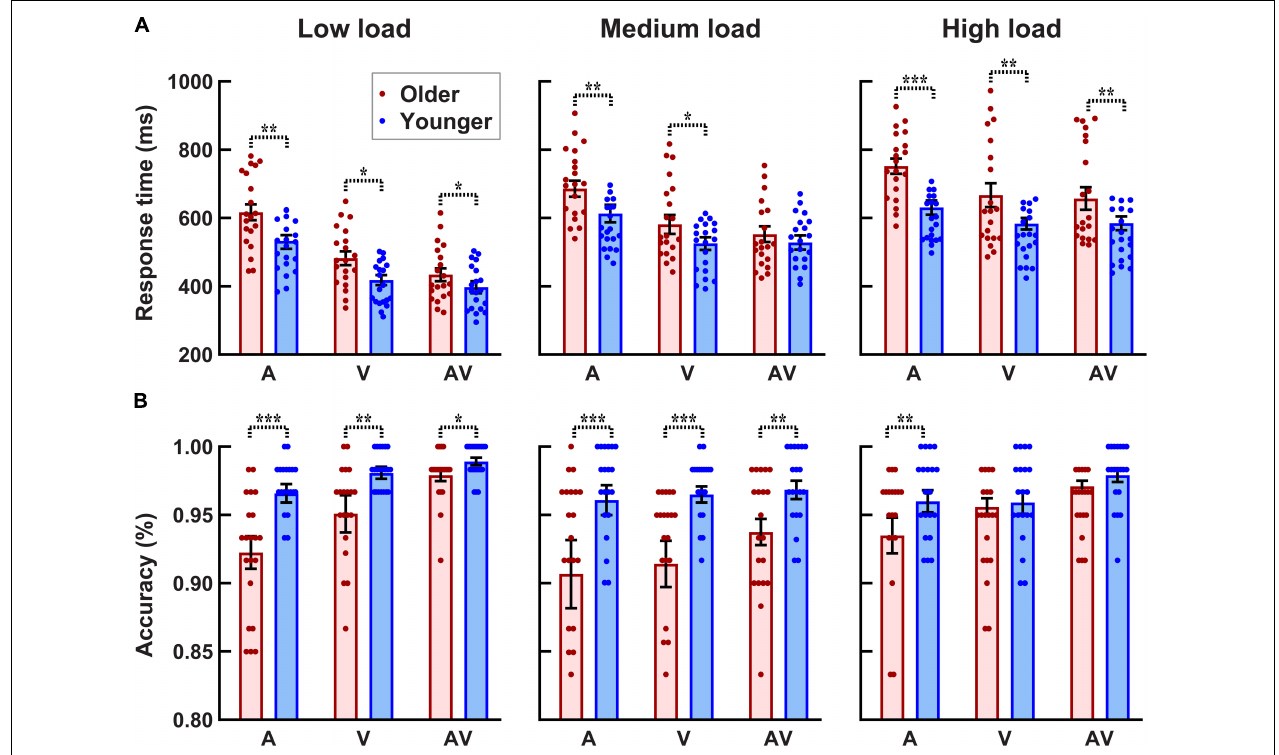
FIGURE 3 | Higher response time (A) and lower accuracy (B) for older adults than for younger adults under all visual perceptual-load conditions. * p < 0.05, ** p < 0.01, *** p < 0.001. Low load, low visual perceptual-load condition; Medium load, medium visual perceptual-load condition; High load, high visual perceptual-load